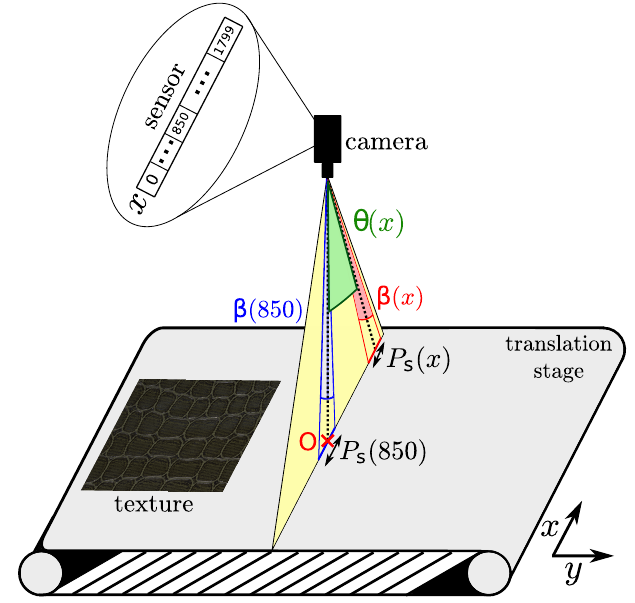
Figure 1. HySpex VNIR-1800 line scan acquisition process and cross-track distortion illustration on the x -axis. The camera acquires hyperspectral lines of pixels ( x -axis). The hyperspectral image is obtained by translation of the object onto the y